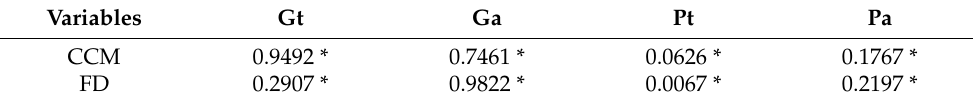
Table 3. Westerlund cointegration